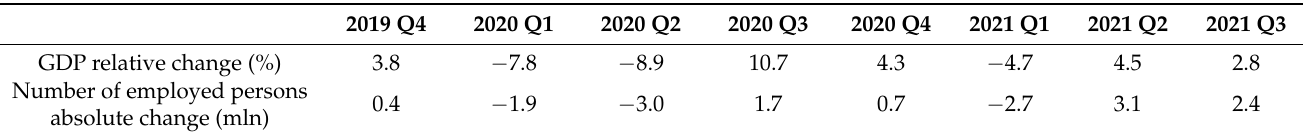
Table 1. Changes in GDP and number of employed persons in 19 countries of the euro area during COVID 19